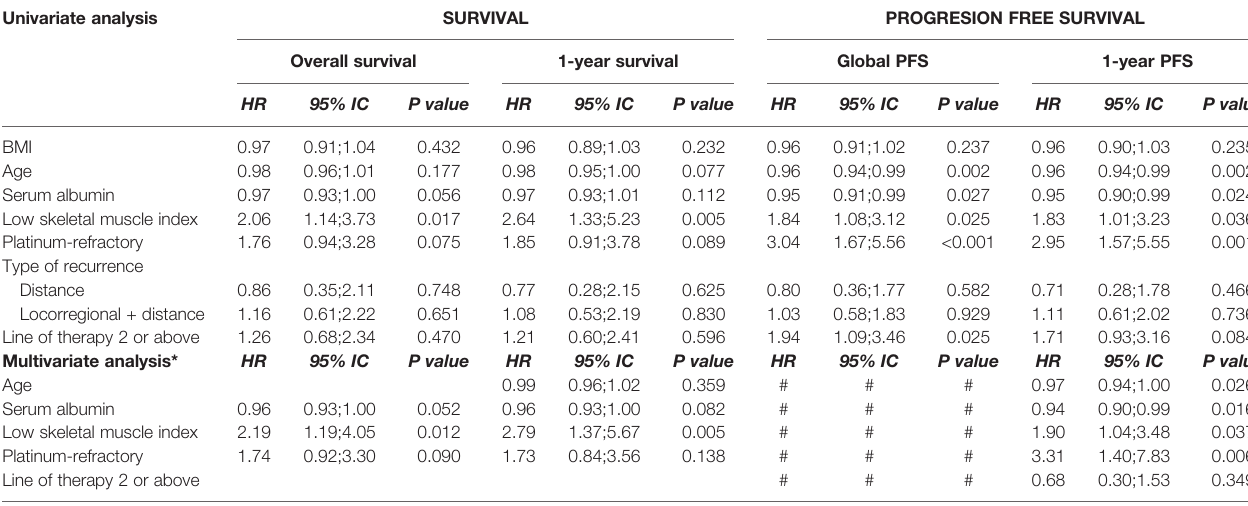
TABLE 2 | Univariate and multivariate analysis examining OS, one-year survival, global PFS and one-year PFS in association with skeletal muscle index (SMI)